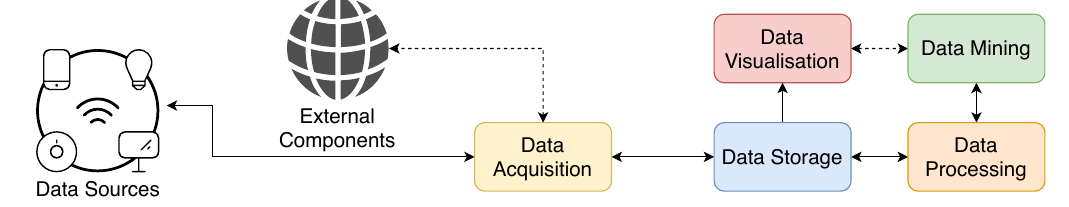
Figure 1. Key components that compose an IoT